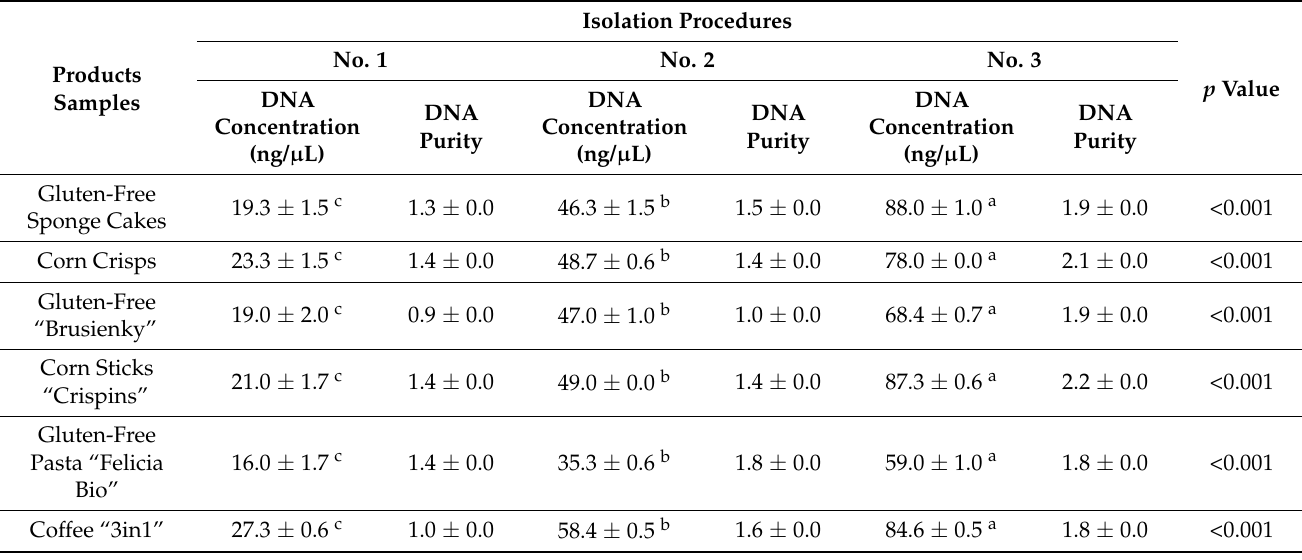
Table 3. Means and their standard deviations (SD) of isolated DNA from